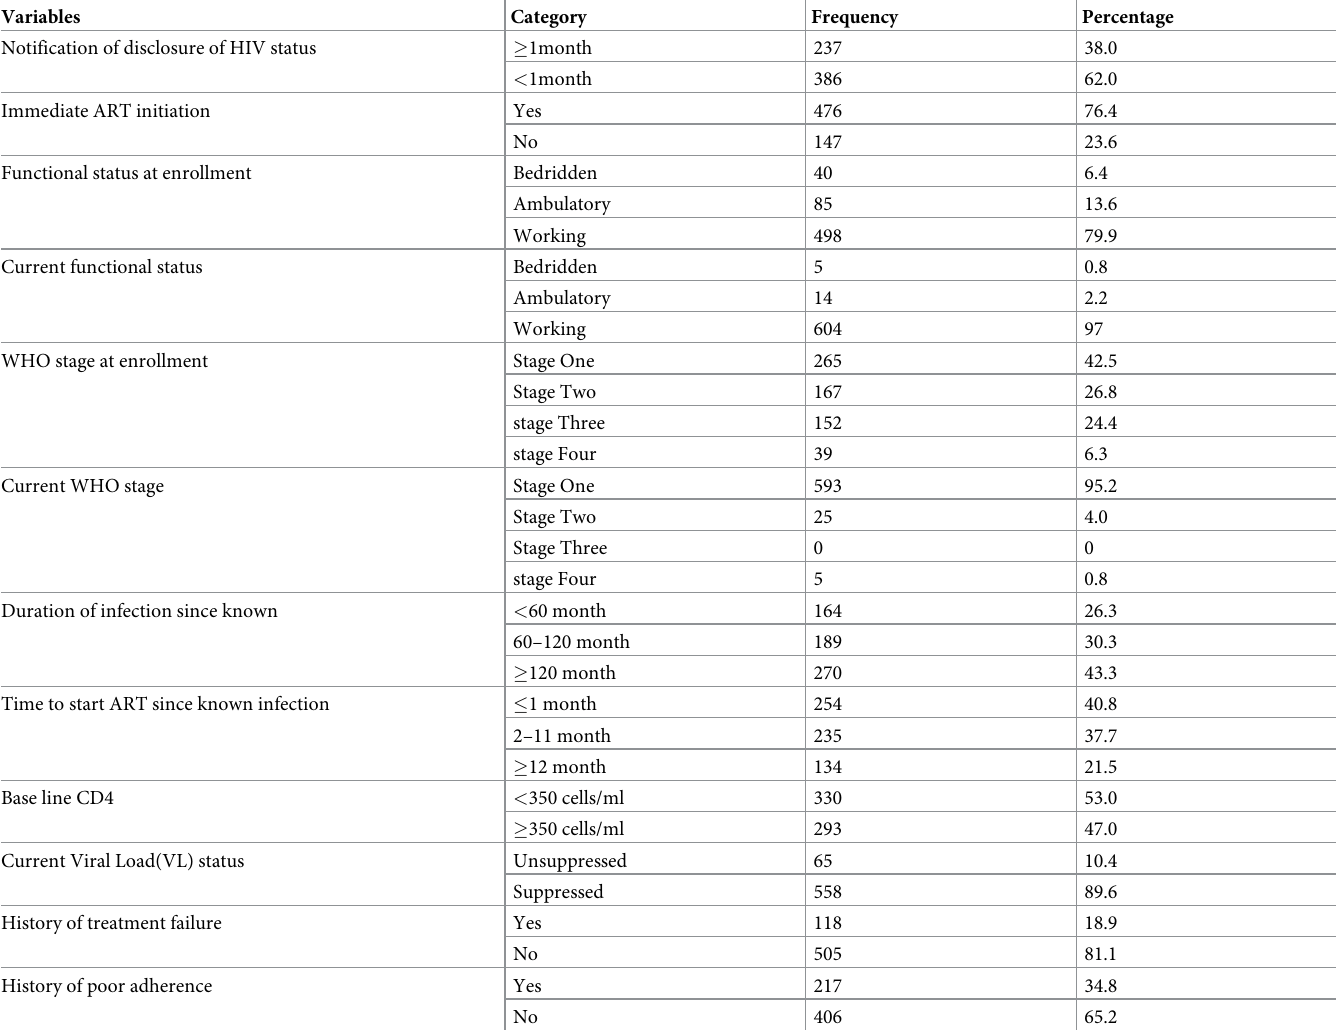
Table 6. Clinical and behavioral characteristics of HIV index cases in Sodo town, Southern Ethiopia, 2021 (N =